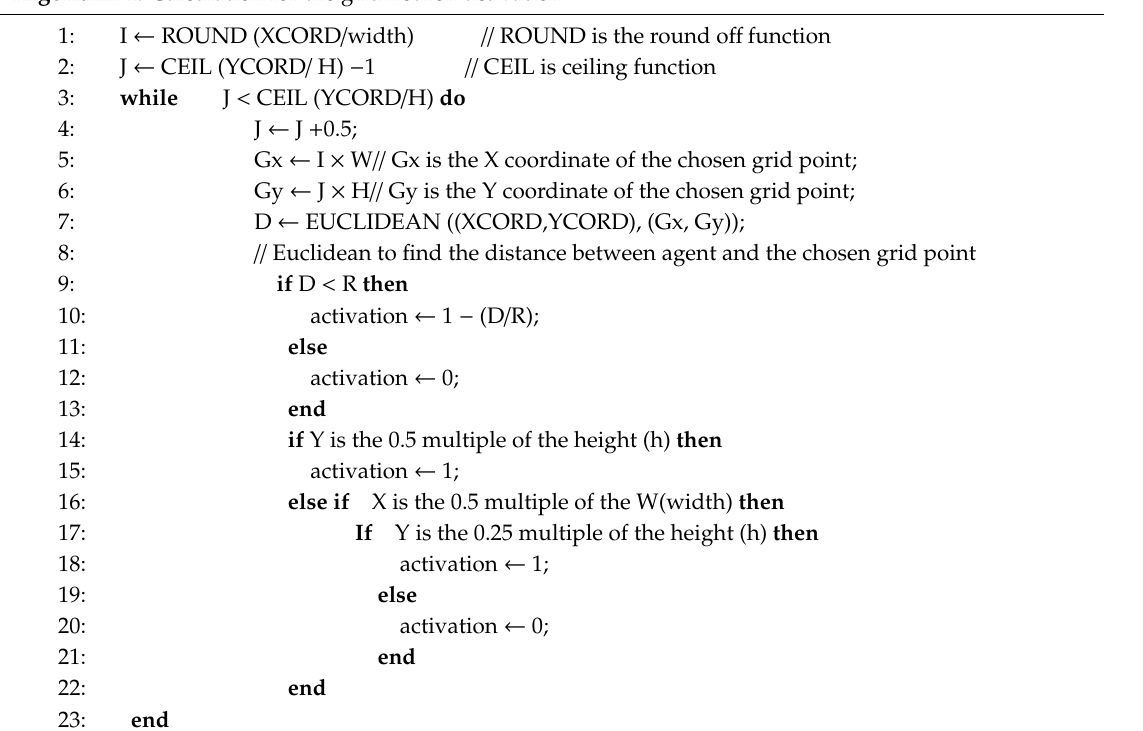
Algorithm 1: Calculation for the grid neuron